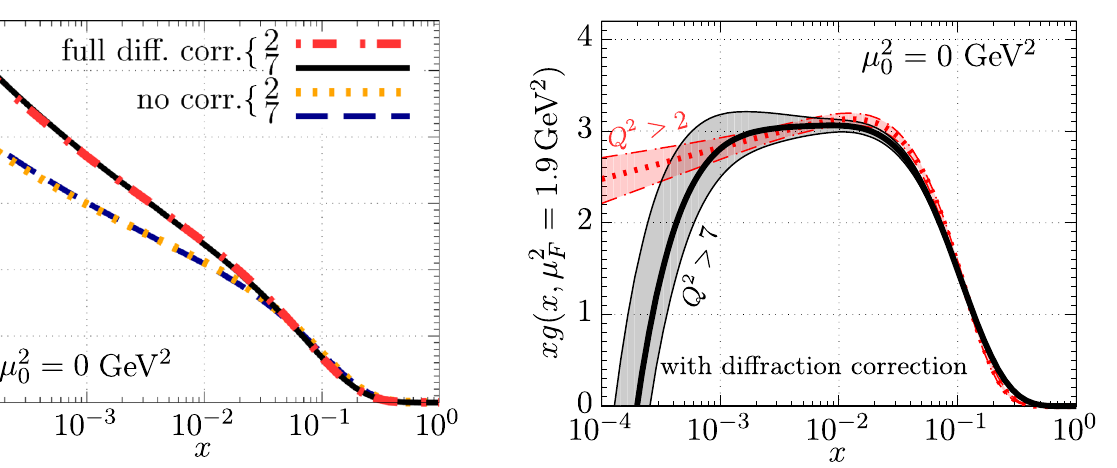
Fig. 6 Theeffectofabsorptivecorrectionsonthegluondensityatscale μ 2 = 5GeV 2 . At this relatively low scale, the gluons already grow F with x decreasing. The fits using data with Q 2 > 2GeV 2 and with Q 2 > 7GeV 2 essentially gives the same gluon density, demonstrating the stability of the evolution from 2 to 7 GeV 2